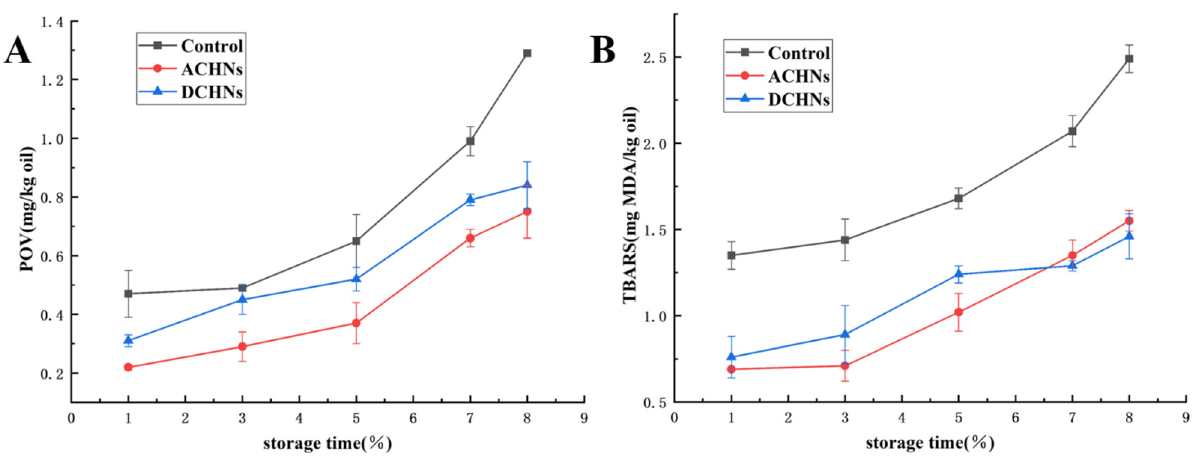
Figure 10. ( A ) POV and ( B ) TBARS values of soybean protein and its hydrolysates nanoemulsion at different storage times.